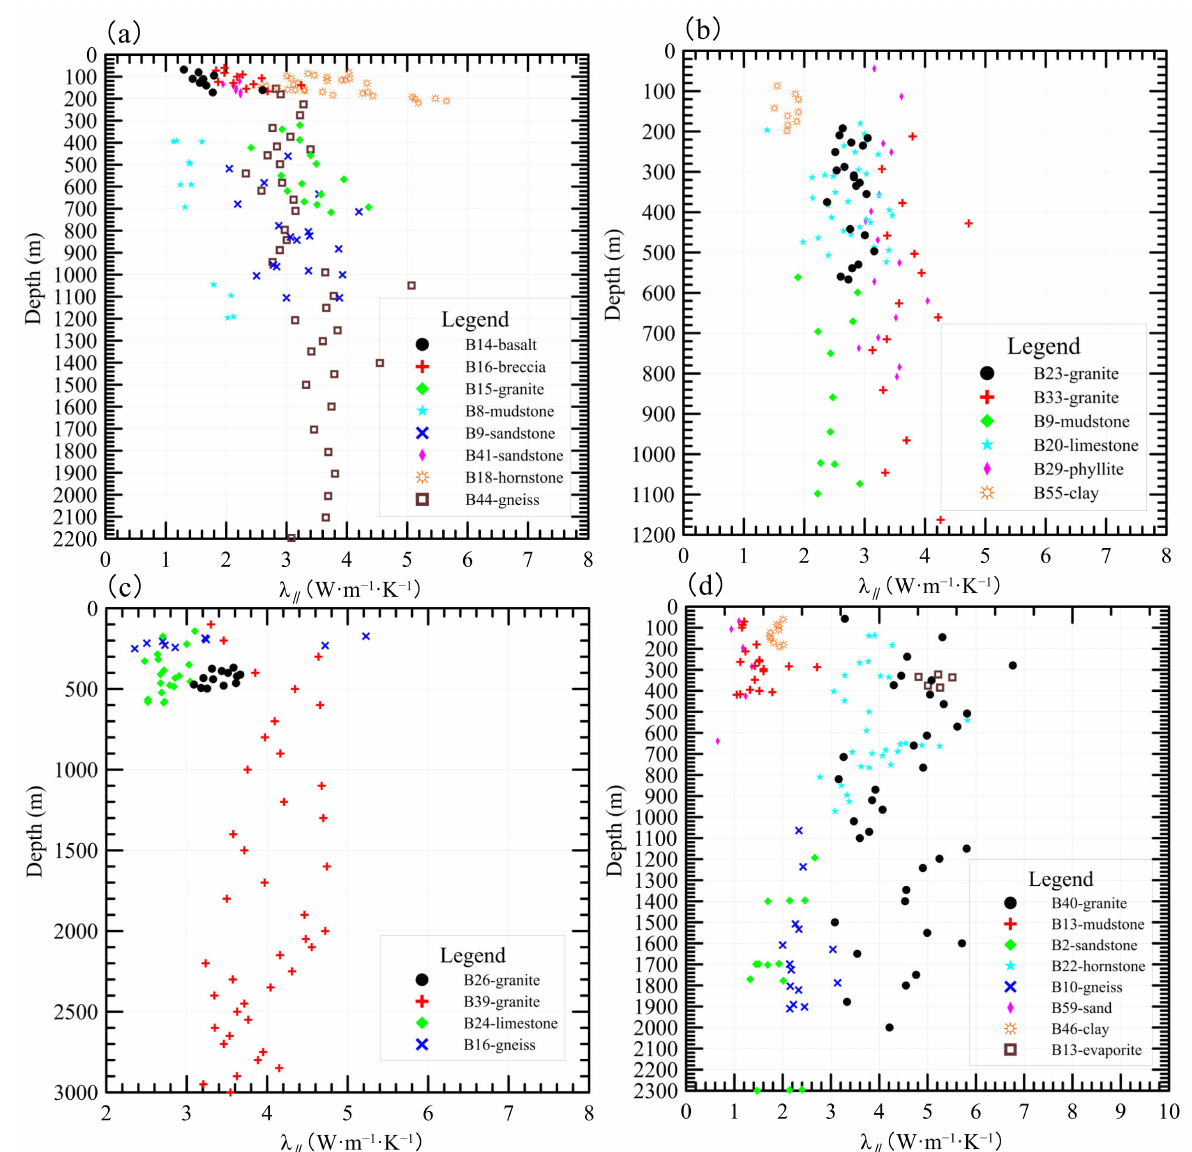
Figure 4. Relationship between thermal conductivity and depth: ( a ) examples of increasing thermal conductivity of rocks with depth; ( b ) examples of rocks with little variation in thermal conductivity with depth; ( c ) examples of decreasing thermal conductivity of rocks with depth; ( d ) examples of irregular fluctuations in the thermal conductivity of rocks with depth (B14: number 14 borehole in Table